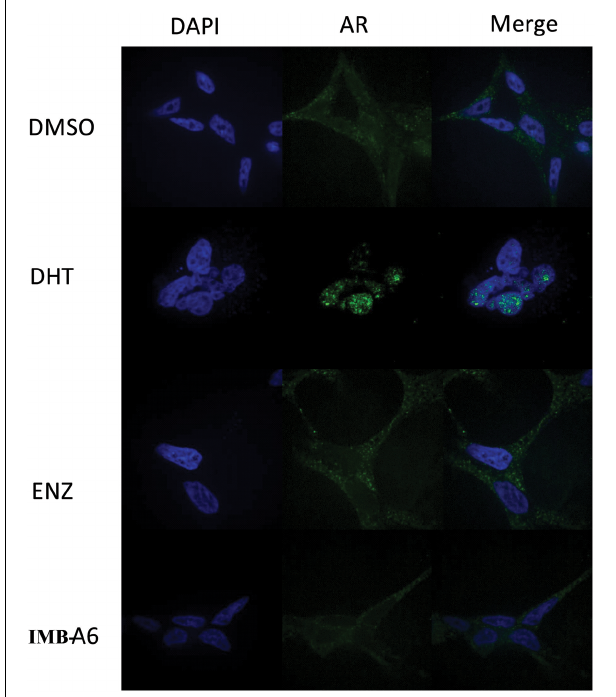
FIGURE 5 | IMB-A6 efficiently inhibits DHT induced AR nuclear translocation. LNCaP cells were treated with DMSO, 1 nM DHT, 500 nM enzalutamide and 1 nM DHT, 5 µ M IMB-A6 and 1 nM DHT in confocal assay. The counterstain DAPI was used to visualize cell